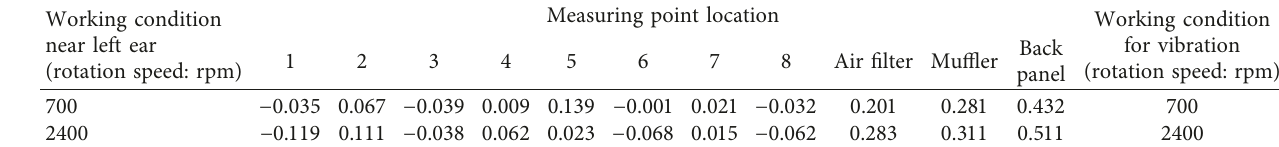
Table 4: Correlation coefficients.